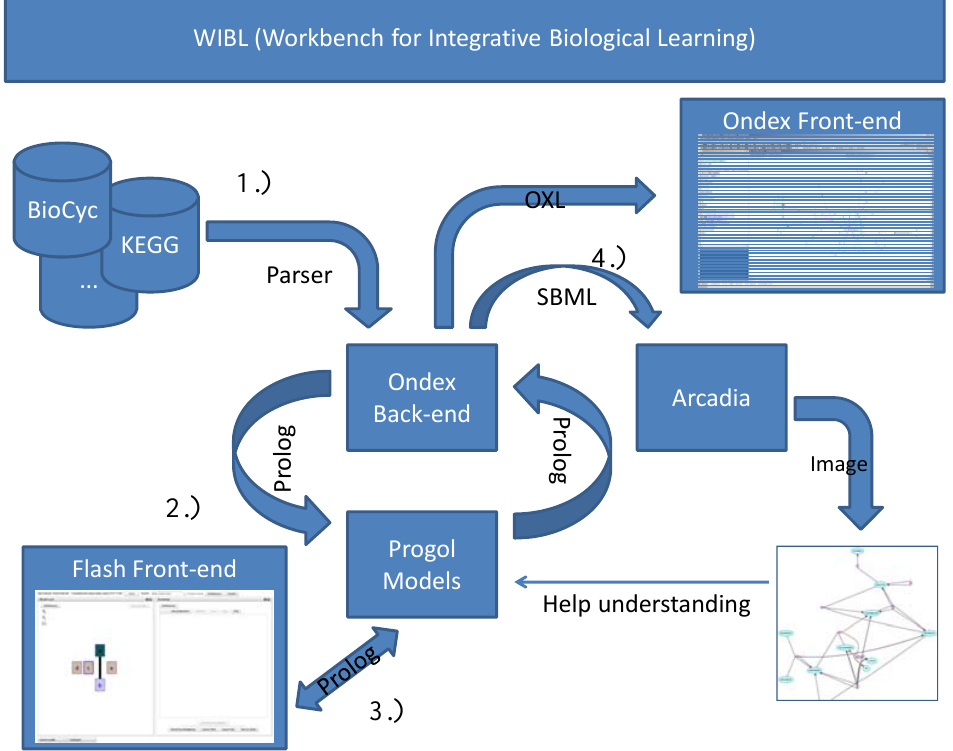
Figure 1 Interplay of the different components of WIBL: 1.) Assembly of background knowledge using Ondex back-end, 2.) Input of background knowledge as Prolog into Progol models, 3.) Rendering and modification of models using WIBLs flash-based front-end, 4.) Export of models into OXL or SBML and applicability to external tools like Arcadia pathways and Ondex front- end.